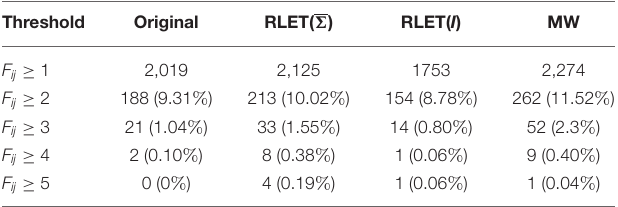
TABLE 1 | The number of detected anomalies using original matrices, harmonized matrices under Rigid Log-Euclidean Translation (RLET) to the global mean 6 , harmonized matrices under RLET to the identity matrix I , and harmonized matrices under matrix whitening, according to the chosen frequency threshold.